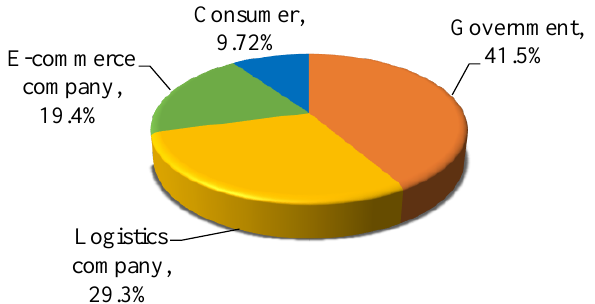
Figure 4. Consumer cognition on the responsible subject for reducing express packaging pollution.